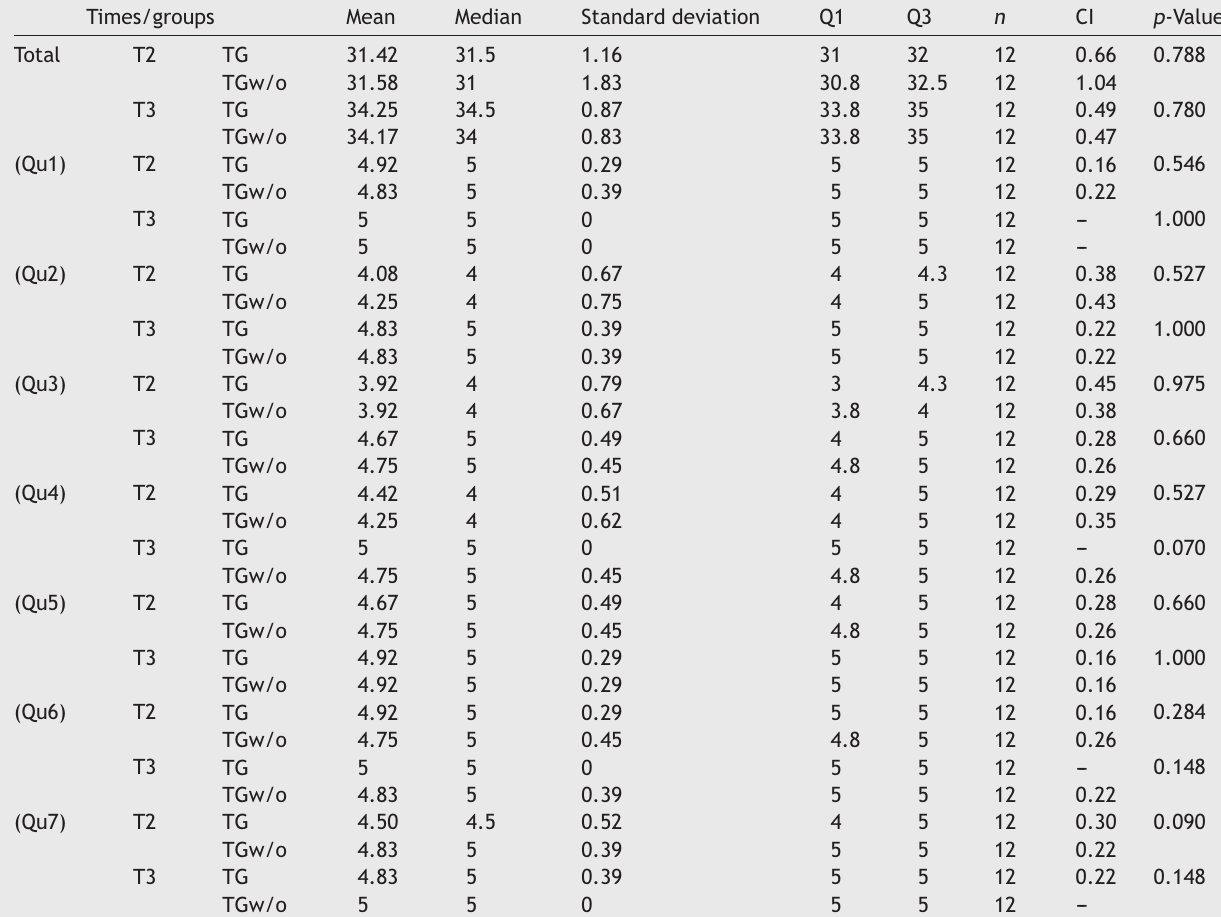
Descriptive statistics and comparative study among groups, by time point, for total score and by the IQ-ISAD tool.